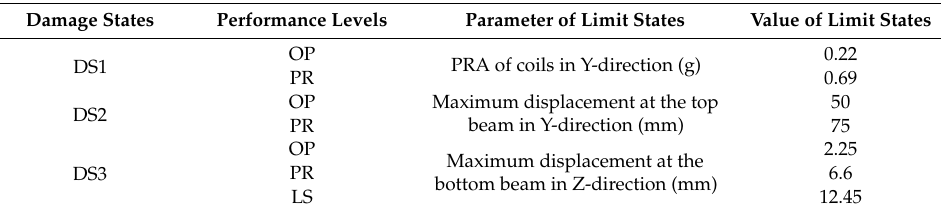
Table 6. Values of limit states of the mold transformer.